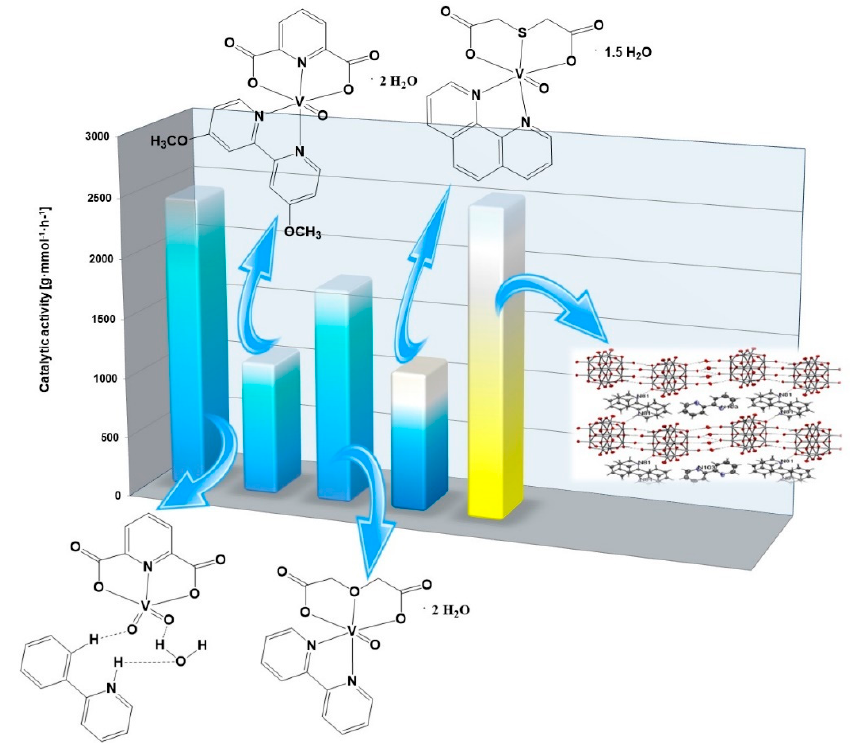
Figure 2. The catalytic activities of vanadium(IV,V) complexes for 3-buten-2-ol oligomerization (based on this work and [28]).